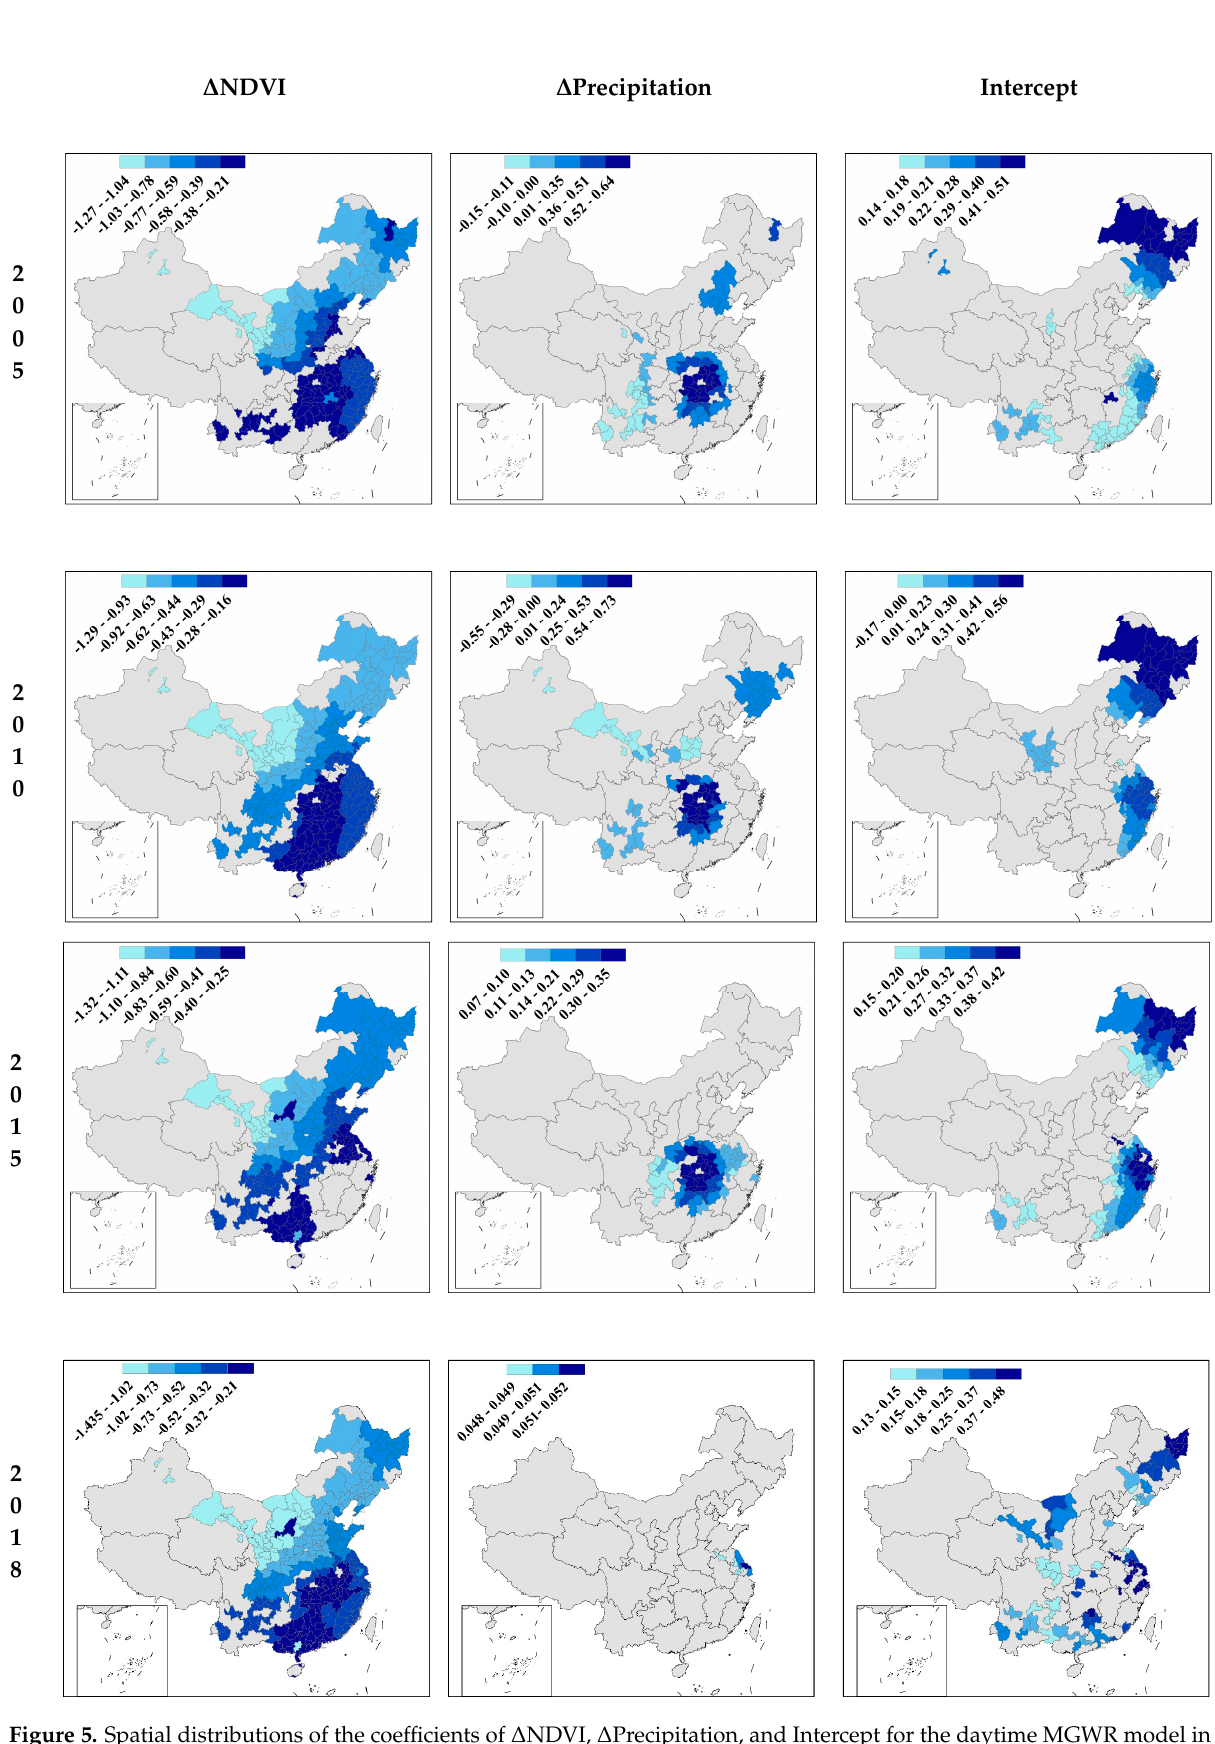
Figure 4. Spatial distributions of MGWR’s local R 2 in 2005, 2010, 2015, and 2018.